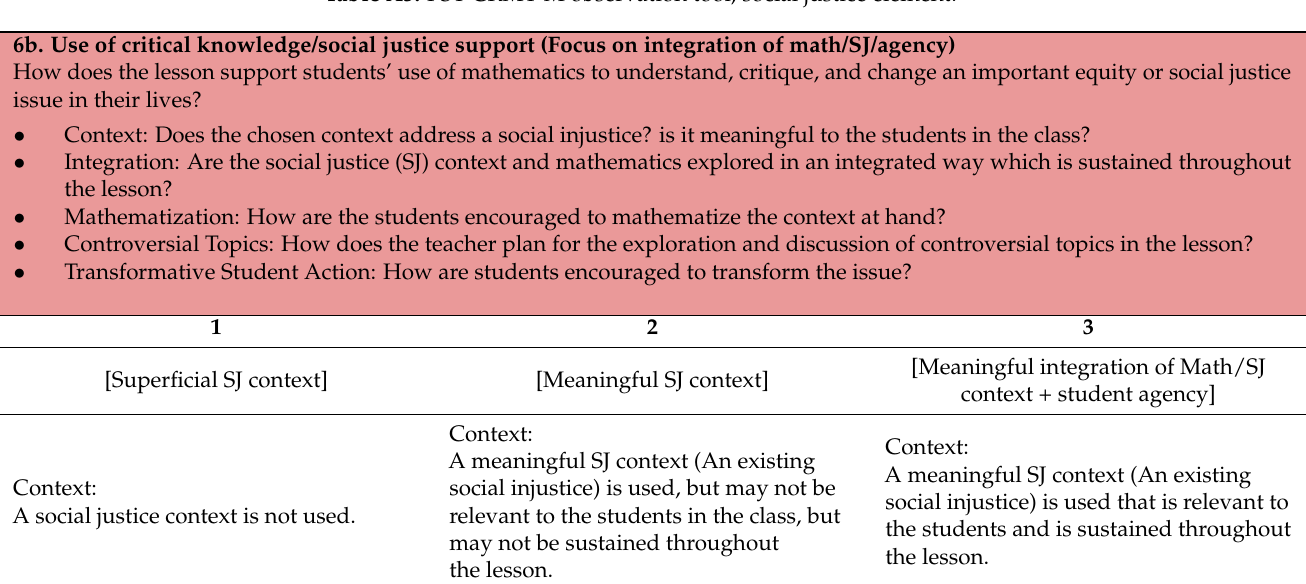
Table A3. PST CRMT-M observation tool, social justice